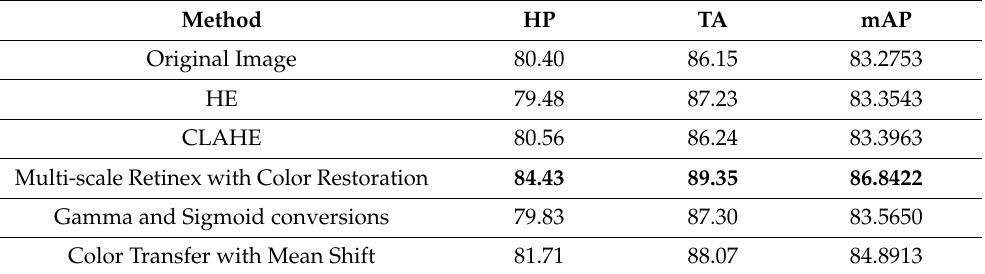
Table 4. mAP results of 3 color transfer methods in 2 polyp classes, HP and